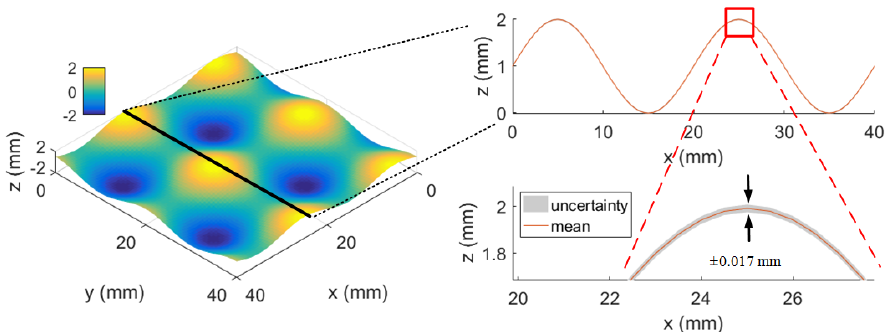
Figure 8. Fused result with the maximum likelihood data fusion method.